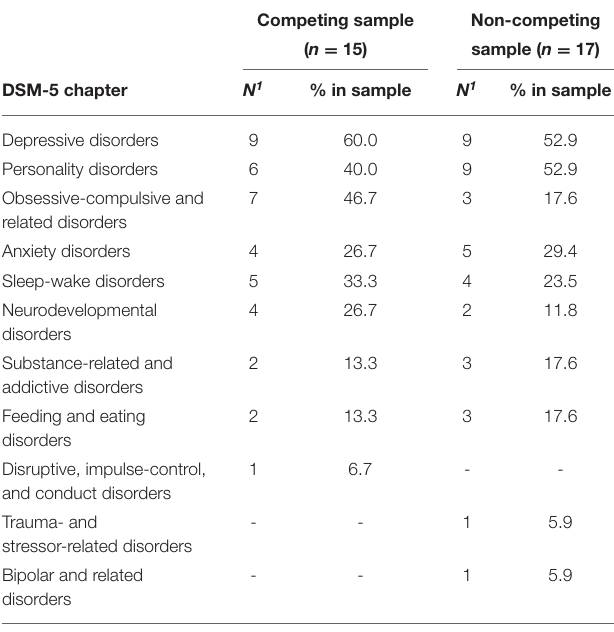
TABLE 3 | Comparison of mental disorders by DSM-5 chapter between competing and non-competing participants. Competing